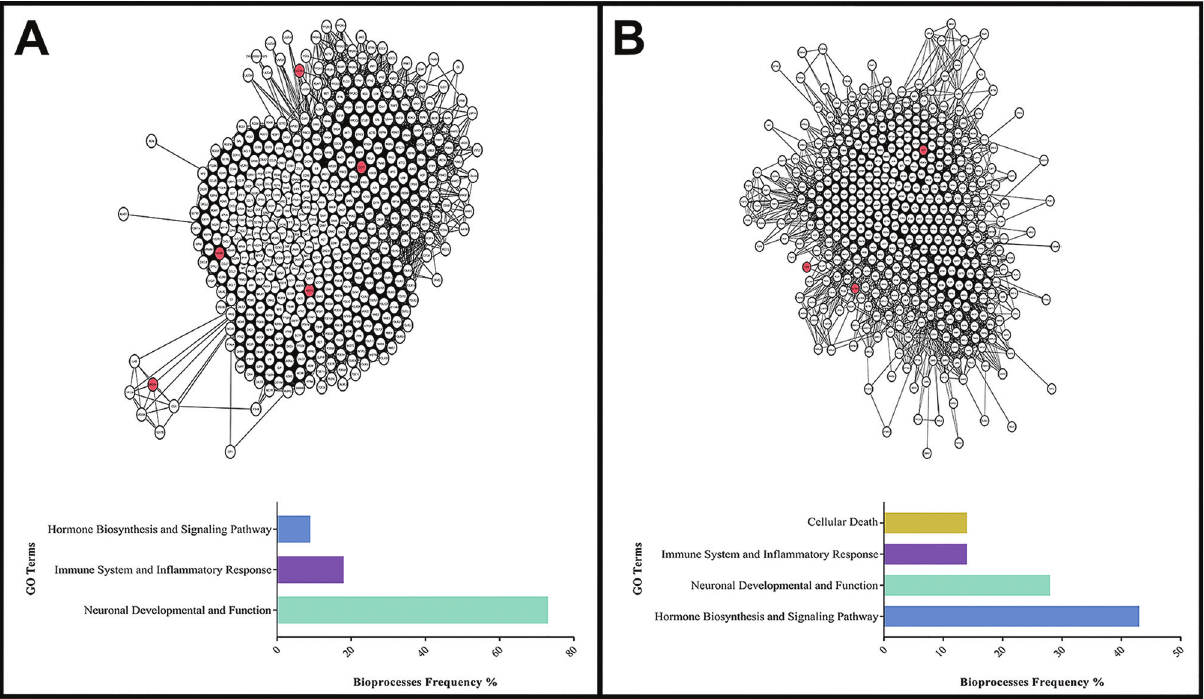
Figure 4 - Subnetworks derived from clustering analysis. Red nodes are target proteins. (A) Cluster 1, with Ci = 94,369, composed of 509 nodes and 24,064 edges. Target proteins: SLC6A3, SRD5A1, CCT5, ADCY2, and TAS2R1. Below, summary of the bioprocess frequency identified in the PPI net- work(B)Cluster8,Ci=23,208,contains471nodesand5477edges.Targetproteins:SLC6A3,TERT,andTPPP.Below,summaryoftheBioprocessfre- quency identified in the PPI